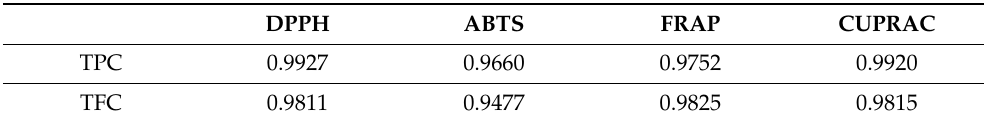
Table 3. The correlation coefficients between total phenolic content and flavonoids with DPPH, ABTS, CUPRAC, and FRAP. DPPH ABTS FRAP CUPRAC TPC 0.9927 0.9660 0.9752 0.9920 TFC 0.9811 0.9477 0.9825